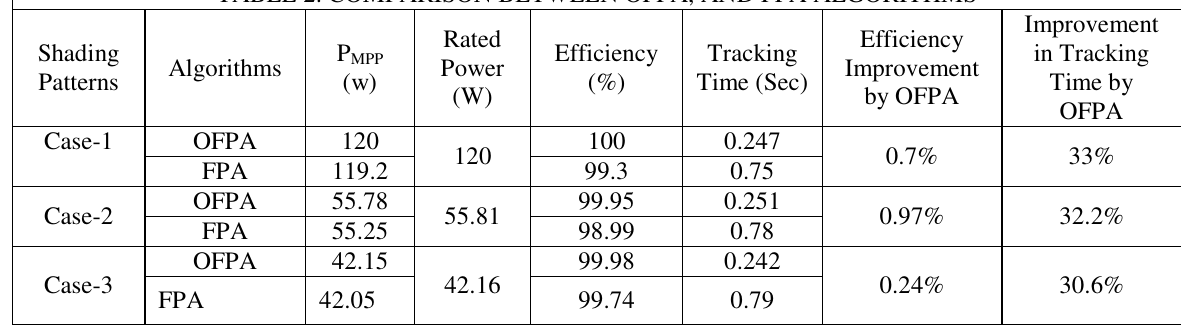
TABLE 2. COMPARISON BETWEEN OFPA, AND FPA